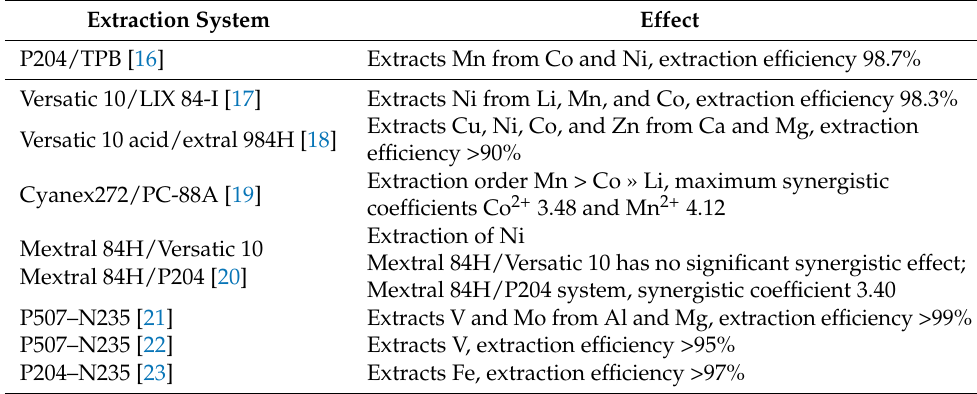
Table 1. Clearly, synergistic extraction system can enhance the metal separation efficiency, and this is a trend of extraction research. Table 1. Orthogonal experimental system for P204